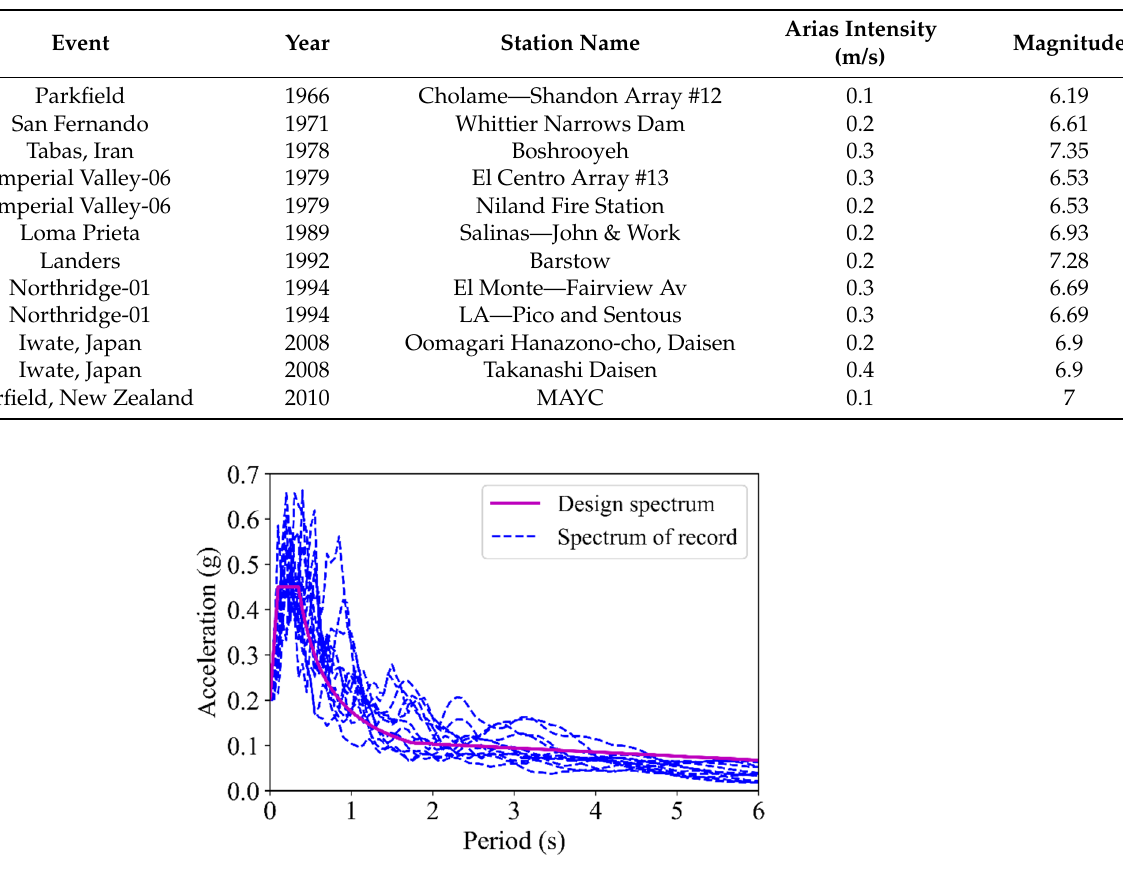
Figure 3. Spectra of the earthquakes.